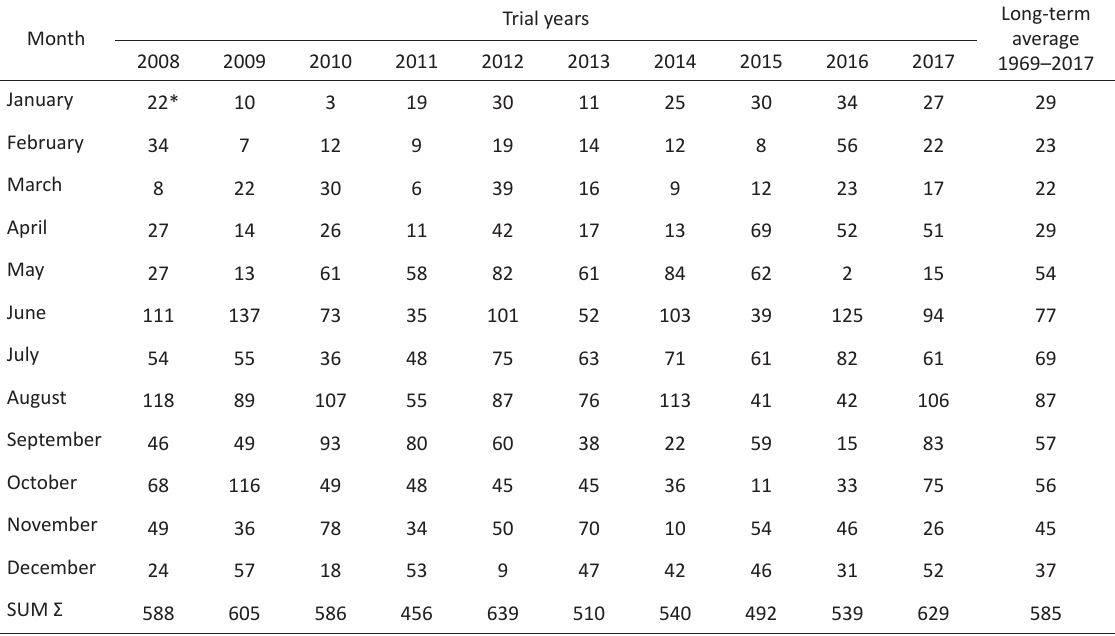
Table 3. Sum of precipitation (mm) in 2008–2017 compared with the long-term average (1969–2017) data